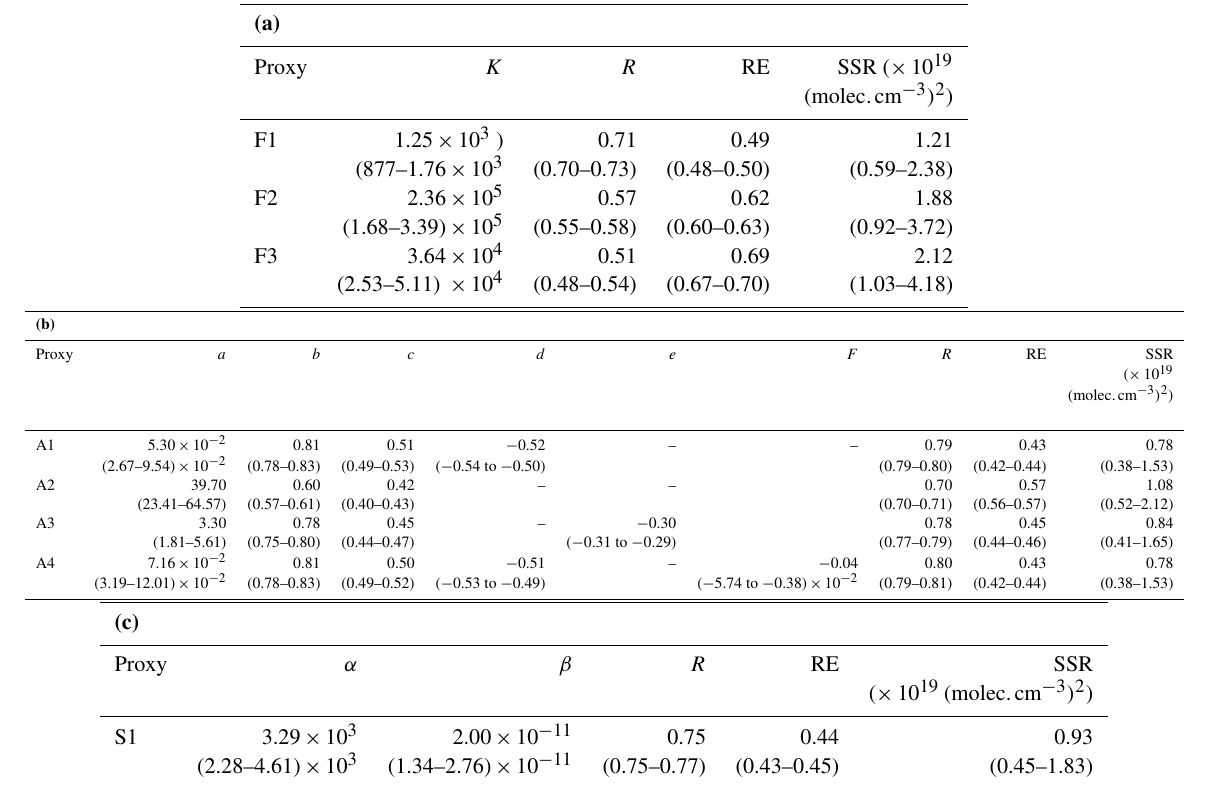
Table 3. Fit results. For each proxy, the correlation coefficient (Pearson) between observed [H 2 SO 4 ] and the predicted values ( R ), the relative error (RE) and the sum of squared residuals (SSR) are also reported. Numbers in parentheses indicate the 25th and 75th percentiles of the corresponding fitting parameter or performance indicator derived from the bootstrap resamples. For simplicity, the results are reported separately for the three proxy families: (a) F1–F3, which are the proxies with powers fixed to − 1 or 1 for all variables; (b) A1–A4, which have individual adjusted powers for each variable; and (c) S1, which includes the additional H 2 SO 4 sink related to cluster formation. Note that based on corresponding p values, all correlations were found to be significant ( p <